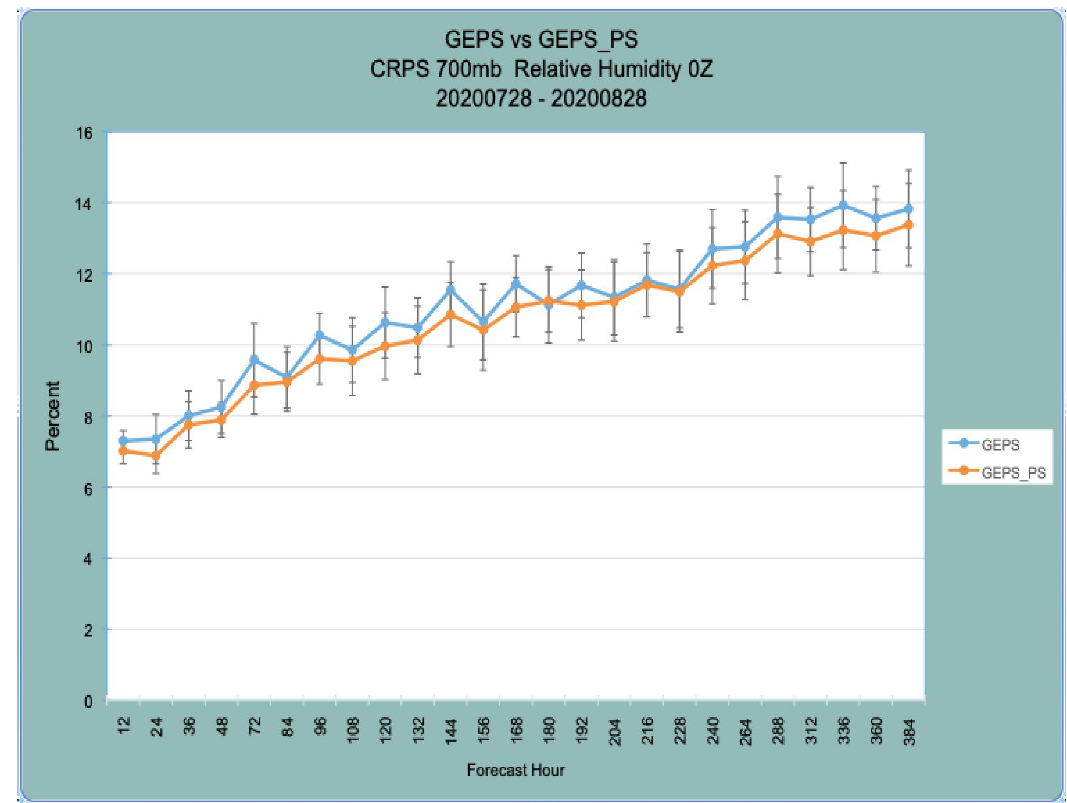
Figure 22. Continuous Ranked Probability Scores for GEPS (blue) and GEPS with GALWEM-GE included (orange) for 250 hPa wind speed as compared to the corresponding UM analysis for the period 28 July 2020 through 28 August 2020. Error bars represent the 95% confidence interval for the CRPS values.